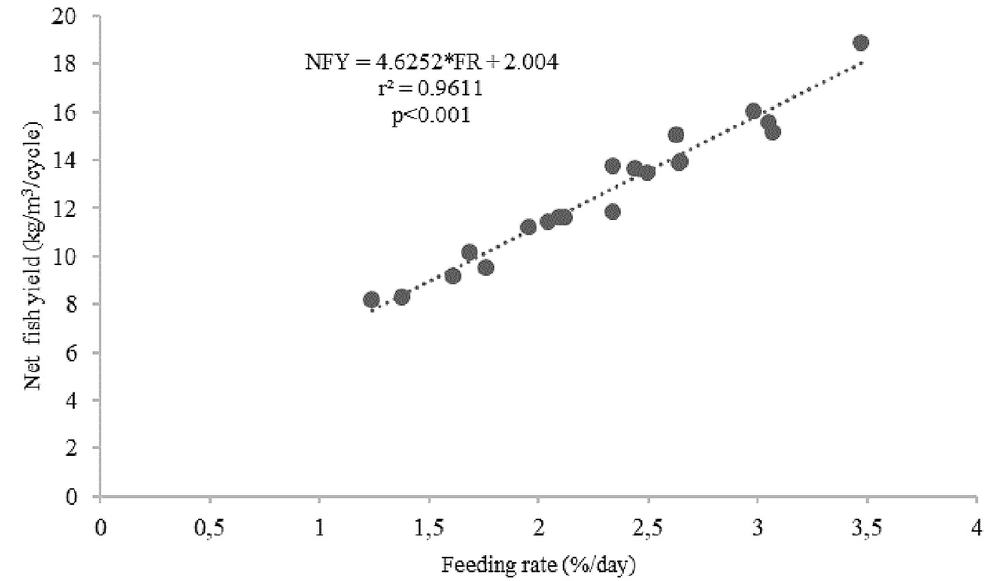
Figure 8. Feeding rates and net fish yield (kg/m 3 /cycle) relationship for giant gourami reared in floating cages.